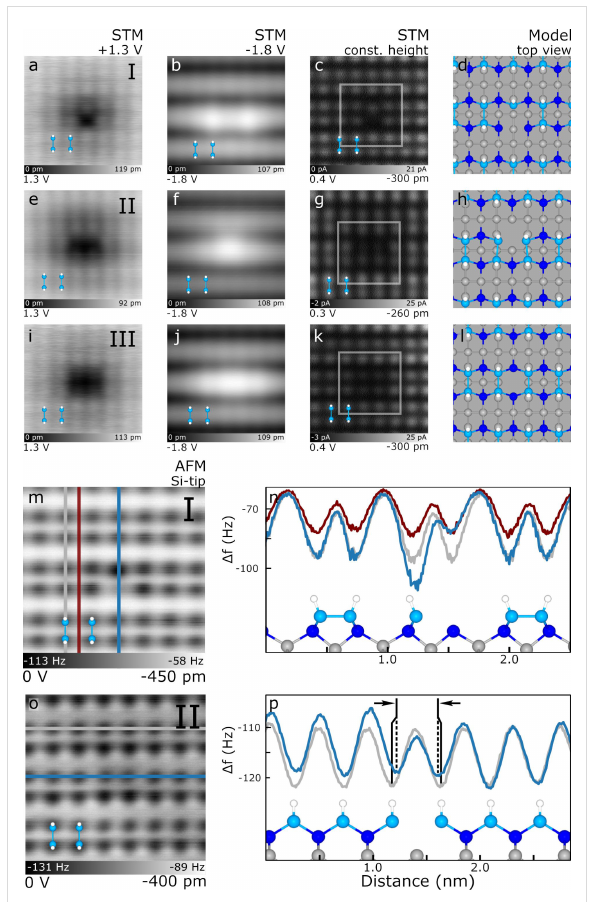
Figure 4: Silicon vacancies at different lattice sites. (a–d), (e–h), and (i–l) show the changing STM appearance of silicon vacancies located at different depths and lattice sites, labelled I, II, and III, respectively. A ball and stick model of the dimer structure is shown as an overlay in each scan (lower left corner, 0.38 nm width). Each STM image is 3.4 nm × 3.4 nm. (m,n) show the line cuts of vacancy I in (a) while (o,p) show the line cuts of vacancy II in (e) with the apparent change in atom separation highlighted (reduction of approximately 15%). Each AFM image is 2.8 nm × 2.8 nm. The defect-including profiles of n and p are indicated in blue, the defect-free profiles are in grey, and a back- ground (between dimer pairs) profile is in burgundy. Colours in the ball and stick models are: H – white, Si dimers – royal blue, back-bonded Si – dark blue, and bulk Si –